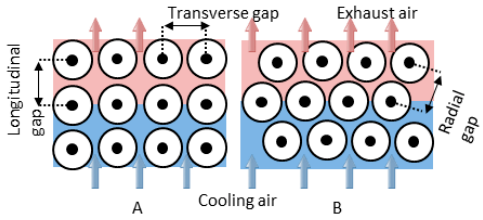
Figure 2. Schematic of aligned ( A ) and staggered ( B ) cell layout optimization adapted from [4,10].